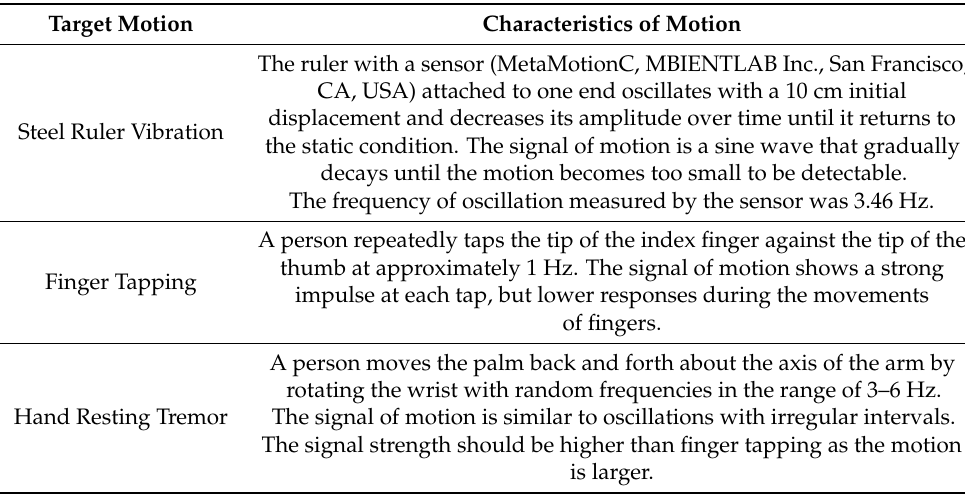
Table 2. Descriptions of the three types of motion and features expected to see in their